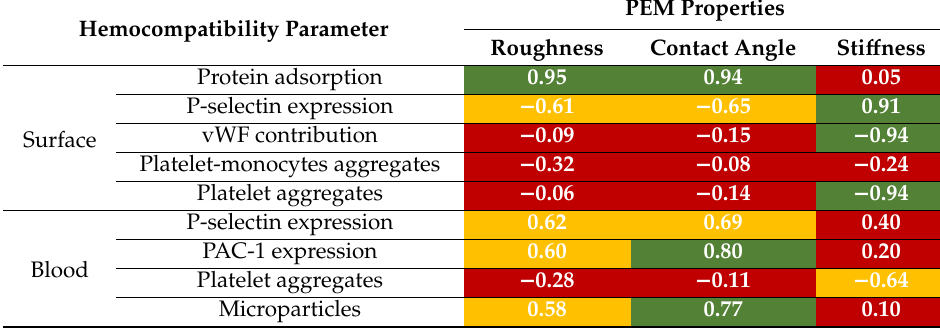
Table 1. Correlation of the Polyelectrolyte multilayer (PEMs) physicochemical properties with hemocompatibility. Colors indicate correlation strength: green—strong correlation; yellow—weak correlation; red—no